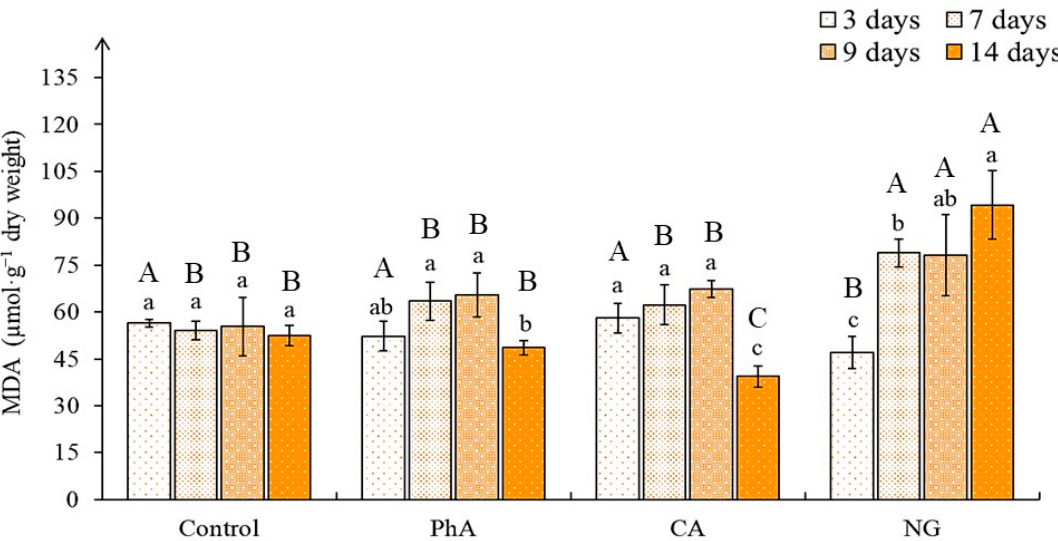
Figure 6. The malondialdehyde (MDA) content in tea callus cultures of various ages grown on the liquid Heller culture medium of the basic composition (Control) or enriched with L -phenylalanine (PhA; 3 mM), trans -cinnamic acid (CA; 1 mM) or naringenin (NG; 0.5 mM). Results are expressed as means ± SDs, n = 3. The significant differences at p < 0.05 are denoted by different Latin letters: uppercase letters indicate significant differences between precursor treatments in alphabetic order from highest to lowest, lowercase letters indicate significant differences between duration of precursor treatments in alphabetic order from highest to lowest. Pairwise multiple comparisons were carried out using Tukey’s range test.